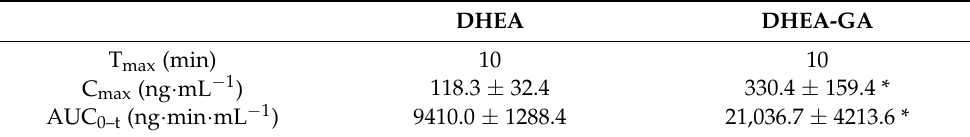
Table 2. Pharmacokinetic parameters of DHEA and DHEA-GA.